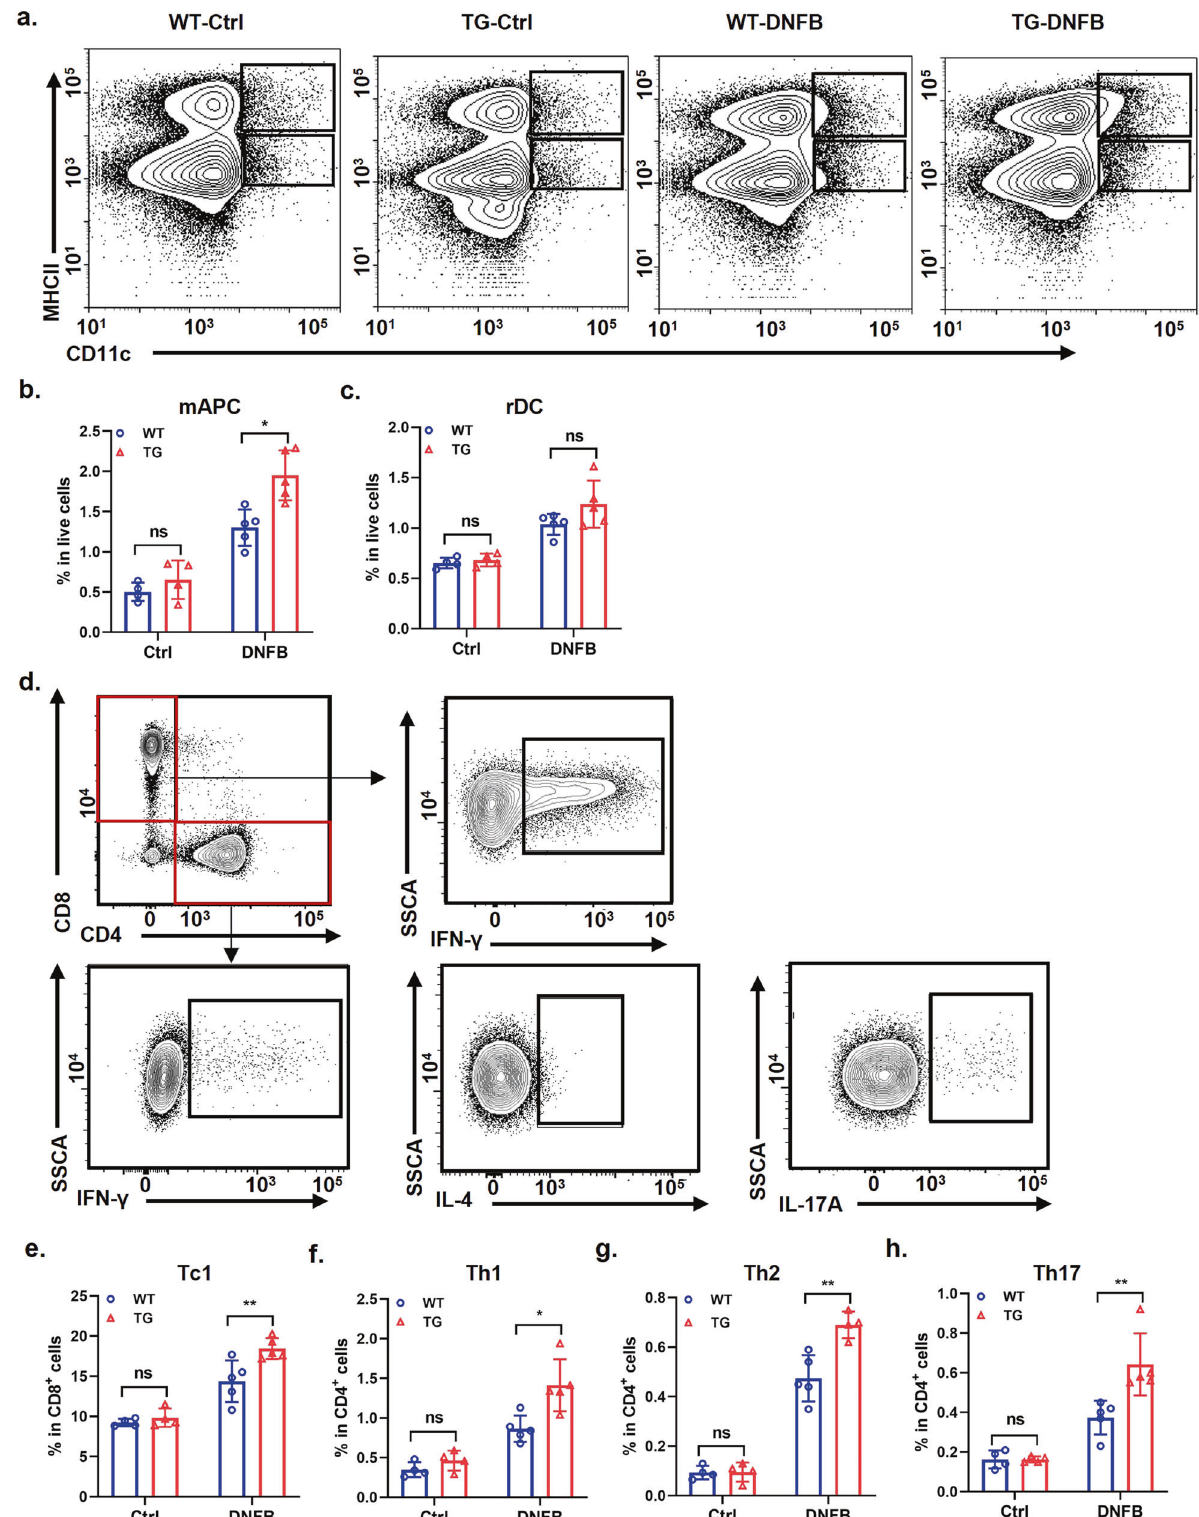
Fig. 4 WFDC12-overexpressing facilitates the migration of mAPCs to lymph nodes and T cells differentiation in lymph nodes. a Analysis of mAPCs and rDCs in lymph nodes of WT and TG mice in control and after DNFB-induced. b and c The proportion of mAPC ( b ) and rDC ( c ) in the total number of live cells in mice ( n = 4 or 5). d Flow cytometric analysis of T cell differentiation in mouse lymph nodes. e – h The ratio of Tc1 ( e ), Th1 ( f ), Th2 ( g ), and Th17 ( h ) in mouse lymph nodes. Data were expressed as mean ± SD. Asterisks indicate statistical signi fi cance based on unpaired or paired T -test; * p < 0.05, ** p < 0.01, *** p < 0.001, ‘ ns ’ indicates no statistical difference.